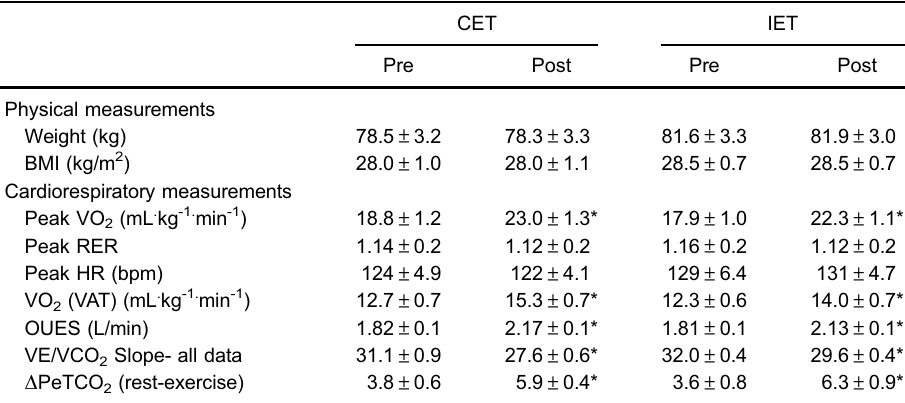
Table 2. Physical and cardiorespiratory parameters in patients with coronary artery disease who performed continuous exercise training or interval exercise training.